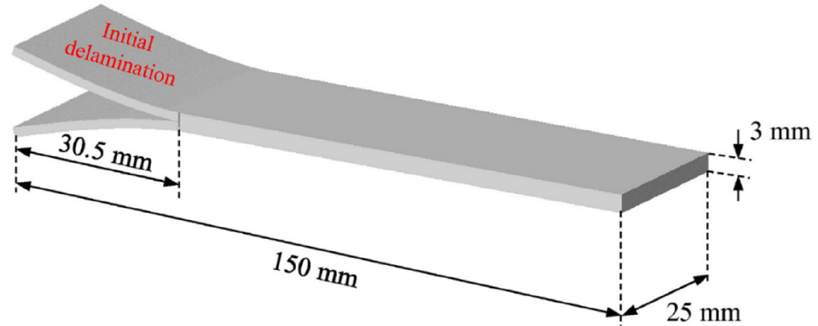
Figure 2. DCB specimen geometry with initial delamination.